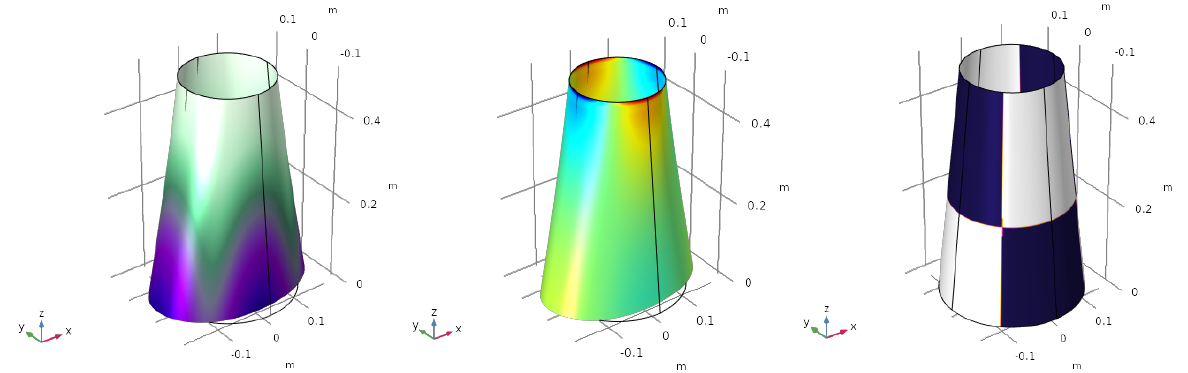
Figure 6. Third vibration mode f 3 = 222 Hz. Mode shape ( left ), electric charge ( centre ) and optimized electrode profile ( right ).